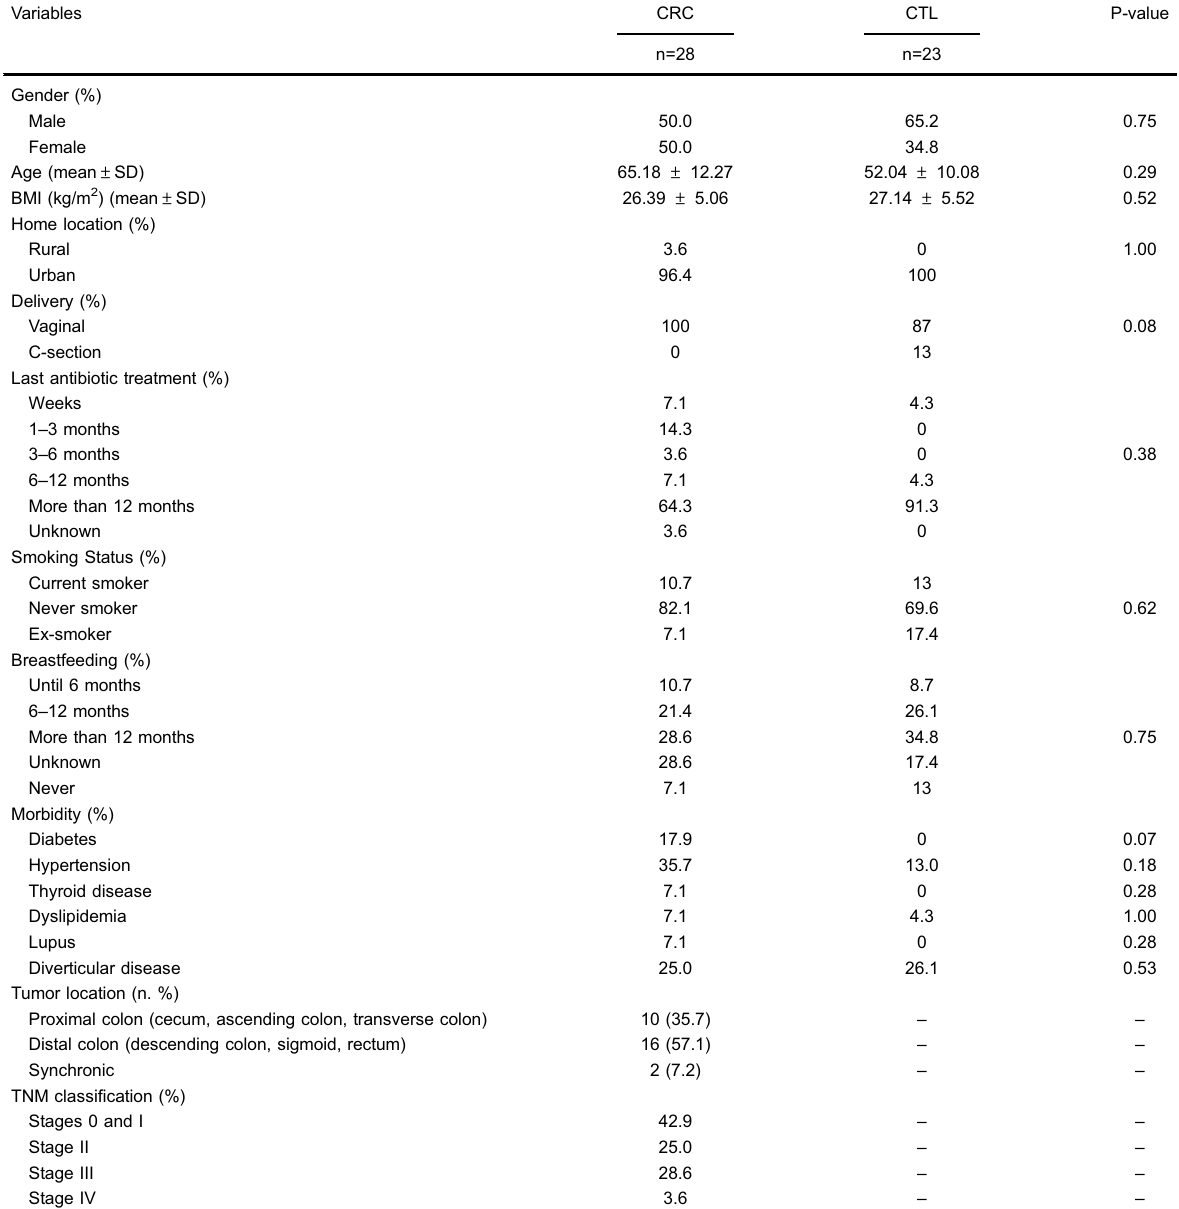
Table 1. Baseline characteristics of control (CTL) and colorectal adenocarcinoma (CRC)